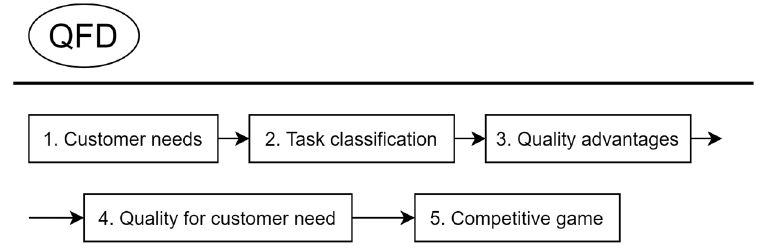
Figure 2. QFD flow chart. Table 2. Six questions applied to the presented case study.